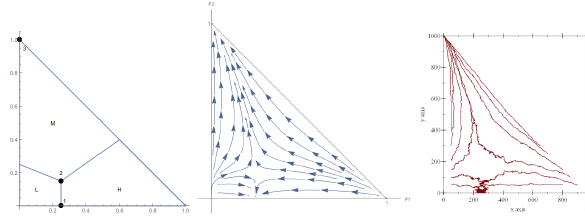
Figure 3: a, Regions of best responses for each pop- ulation state. b, RD of the one shot NDG, with respect to pL and pM . c, The simulated RD approx- imating the prediction in b.